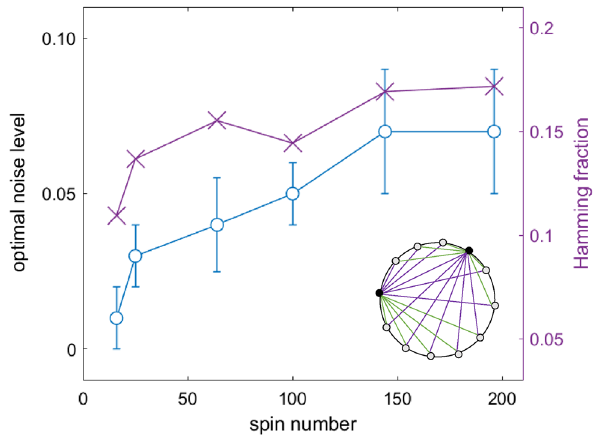
Figure 4: Scaling properties. Optimal noise level (blue circles) as a function of the number of spins for dense Mattis spin glasses (inset graph). Purple dots indicate the measured Hamming fraction ( h / N ) for various system